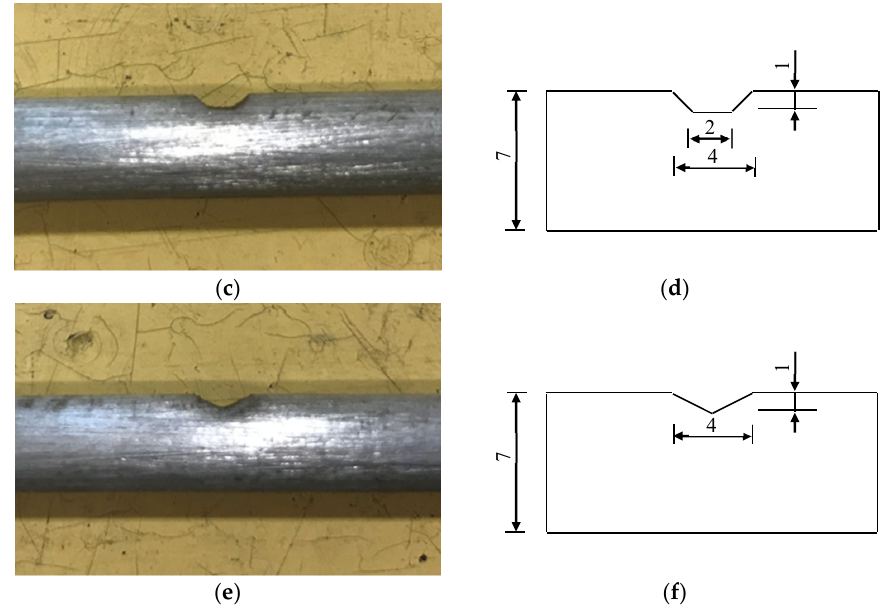
Figure 24. Wire specimens with machine-cut notches of different shapes. ( a ) No. S-1 steel wire specimen; ( b ) dimension of No. S-1 steel wire; ( c ) No. S-2 steel wire specimen; ( d ) dimension of No. S-2 steel wire; ( e ) No. S-3 steel wire specimen; and ( f ) dimension of No. S-3 steel wire.